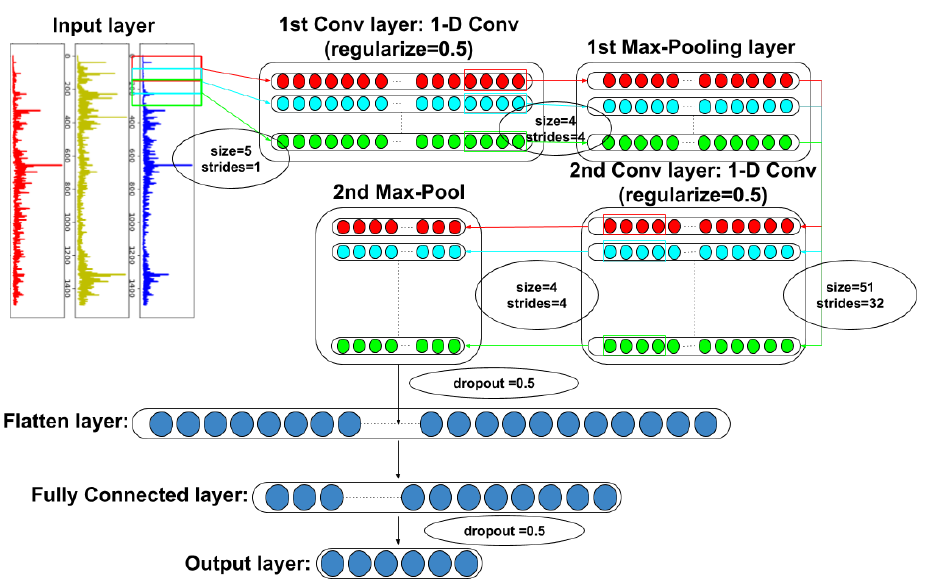
Figure 3. The CNN architecture of this study.